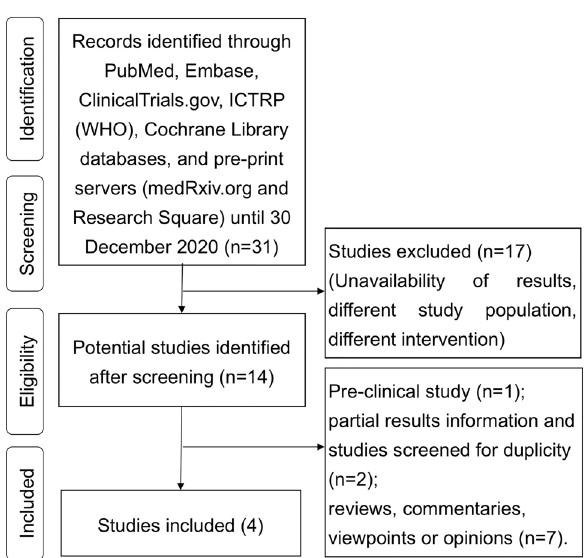
Figure 1. Flowchart depicting the steps of qualitative synthesis of evidence from the